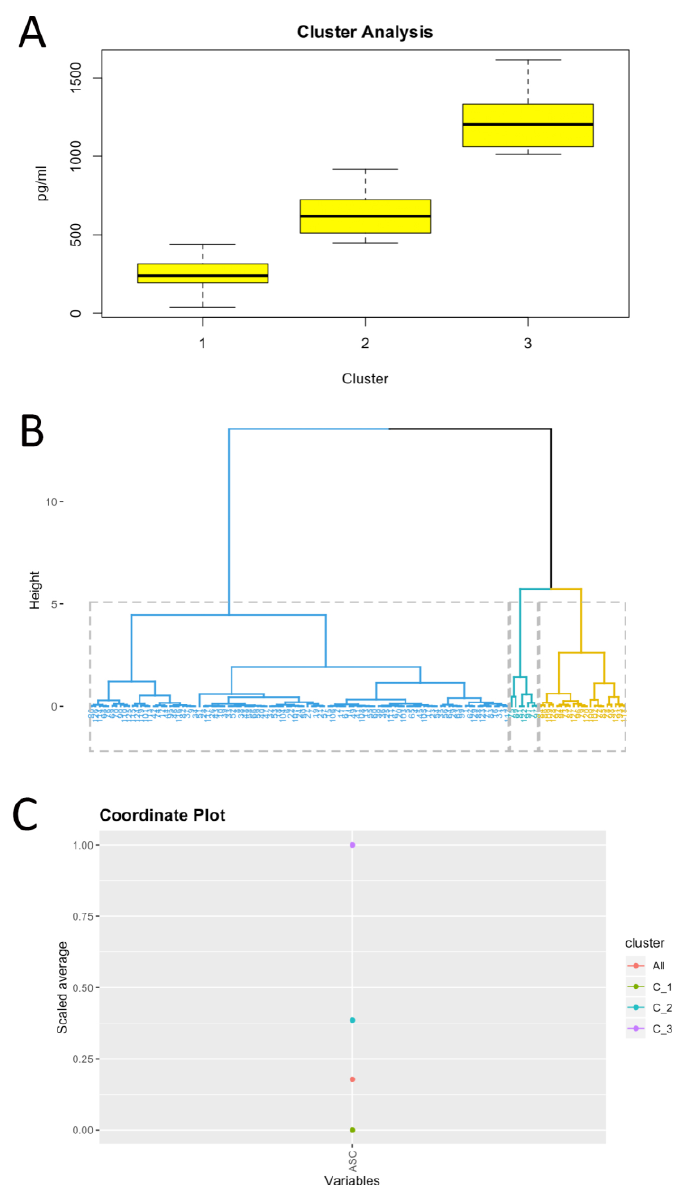
Figure 4. Clustering analysis based on serum ASC protein levels. Clustering using Gaussian Mixture Modeling ( A ), cluster dendrogram using hierarchical clustering ( B ) and coordinate plot ( C ).